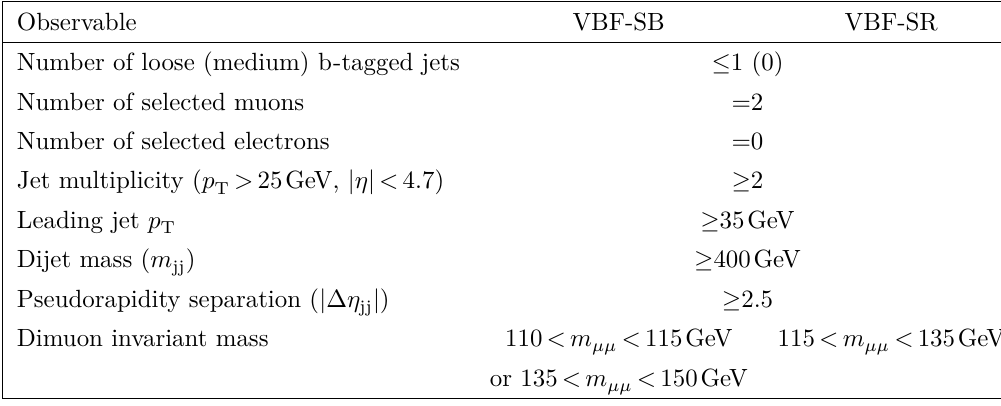
Table 1 . Summary of the kinematic selections used to define the VBF-SB and VBF-SR regions. to the mass sideband region (VBF-SB), which is used as a control region to estimate the background. The VBF-SR is defined to be 20 GeV wide in order to be sensitive to Higgs boson mass hypotheses in the range of 120–130 GeV. A summary of the selection criteria used to define the VBF-SB and VBF-SR regions is reported in table